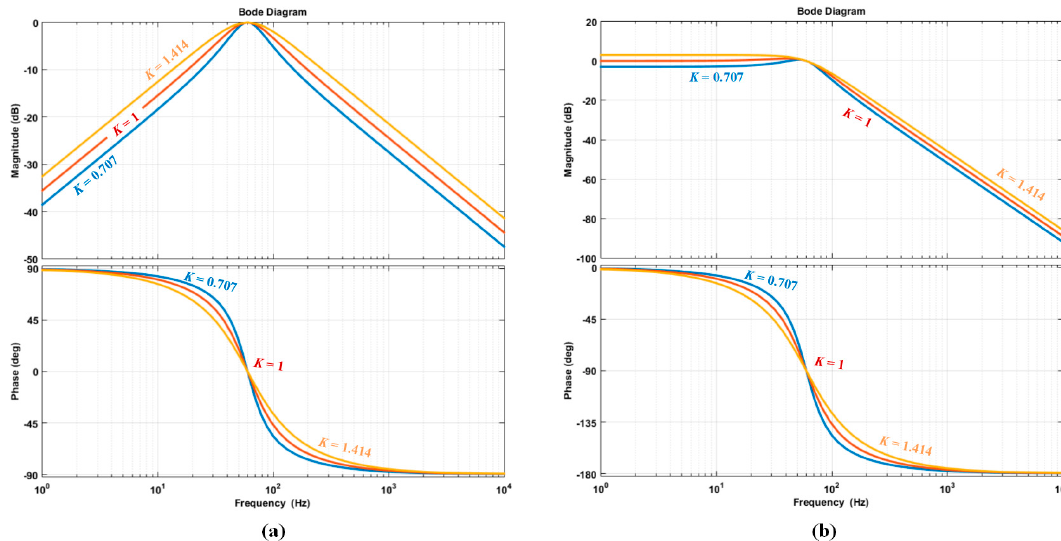
Figure 7. Bode diagram of transfer functions ( a ) G d ( s ) and ( b ) G q ( s ).